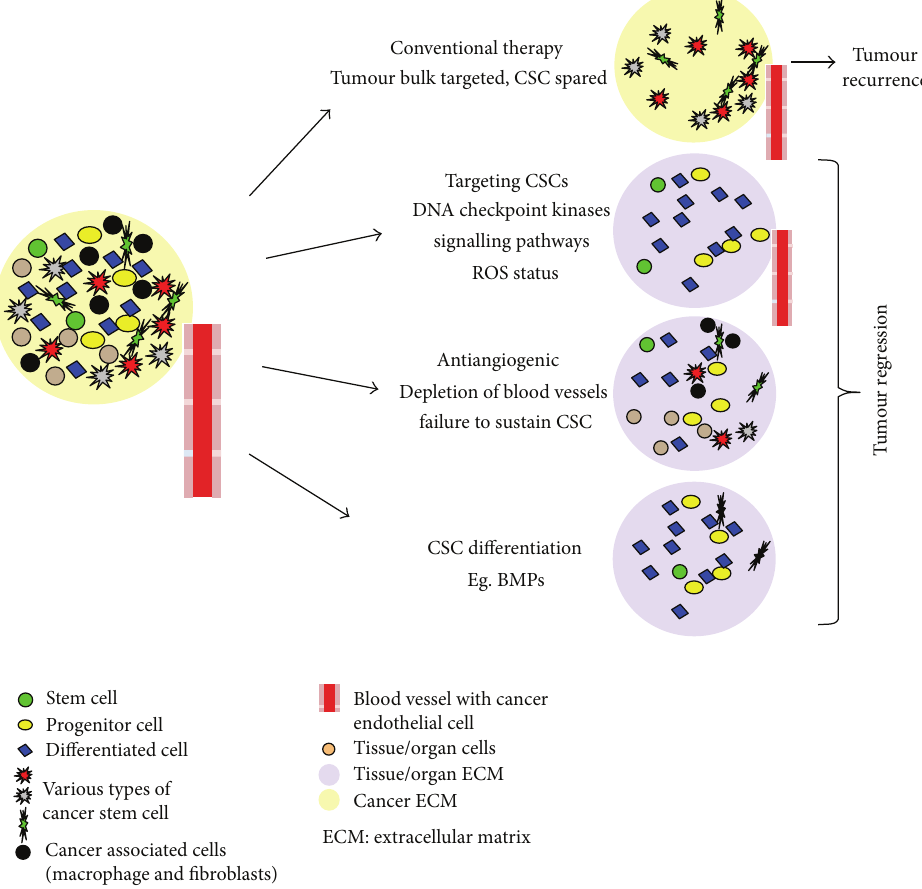
Figure 3: Multistrategic approach in combating cancer. Conventional therapy targets tumor bulk and CSCs are spared. The CSCs, having the potential of self-renewal and to differentiate into various cells, will lead to recurrence. Combination of conventional therapy which potentially allows for tumor debulking and “CSC targeted therapy” which may prevent recurrence and metastasis is advocated. The “CSC targeted therapy” includes (a) specifically targeting CSC by altering signaling pathways and ROS status. (b) Antiangiogenic therapy which will cause depletion of blood vessels and loss of CSC. (c) Certain differentiation factors will help in differentiating CSCs to more mature form and will lead to loss of